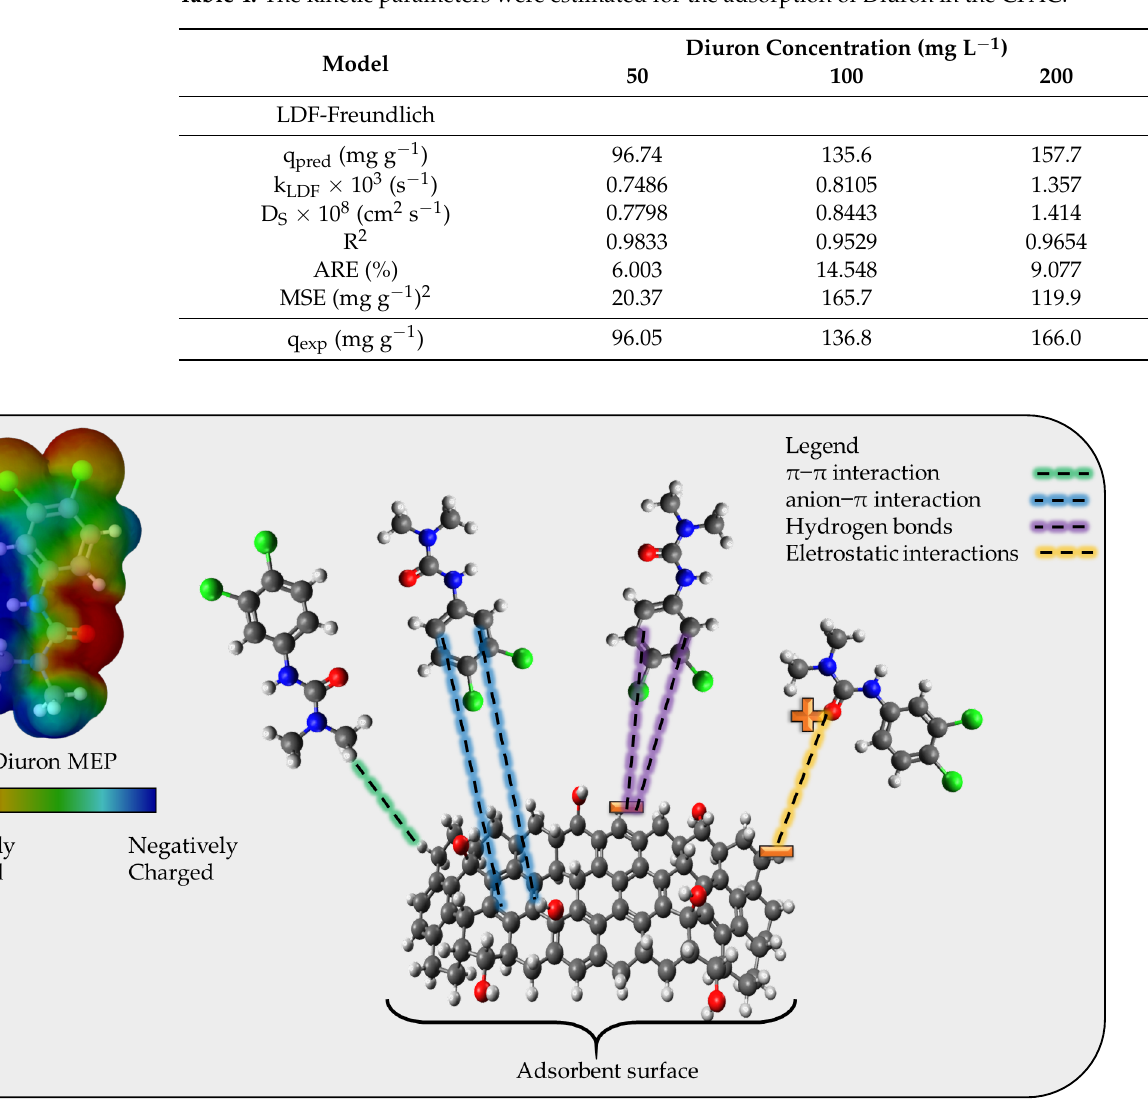
Table 4. The kinetic parameters were estimated for the adsorption of Diuron in the CPAC. Model